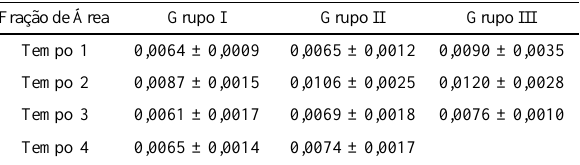
Tabela 7. Valores médios com seus respectivos desvios-padrão das frações de áreas ocupadas por uma mitocôndria nas micrografias dos animais dos grupos I, II e III, submetidos em CEC, a duas horas de isquemia e três horas de reperfusão.